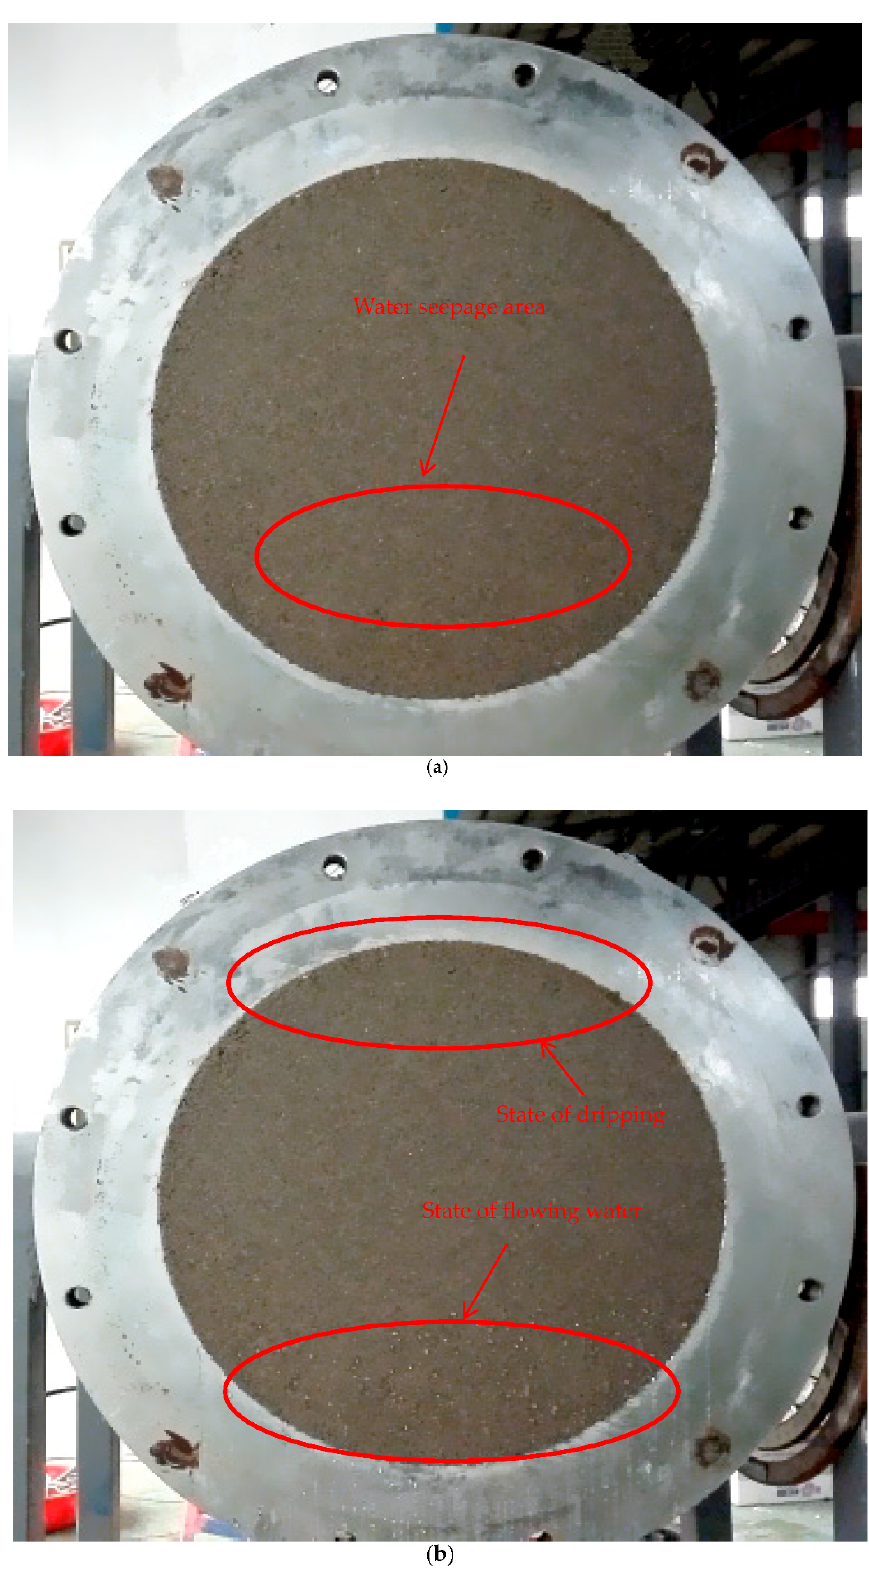
Figure 7. Water seepage stage in front of the tunnel face. ( a ) Water seepage in the lower part; ( b ) the seepage area is covered with the surface of the aquifuge rock.